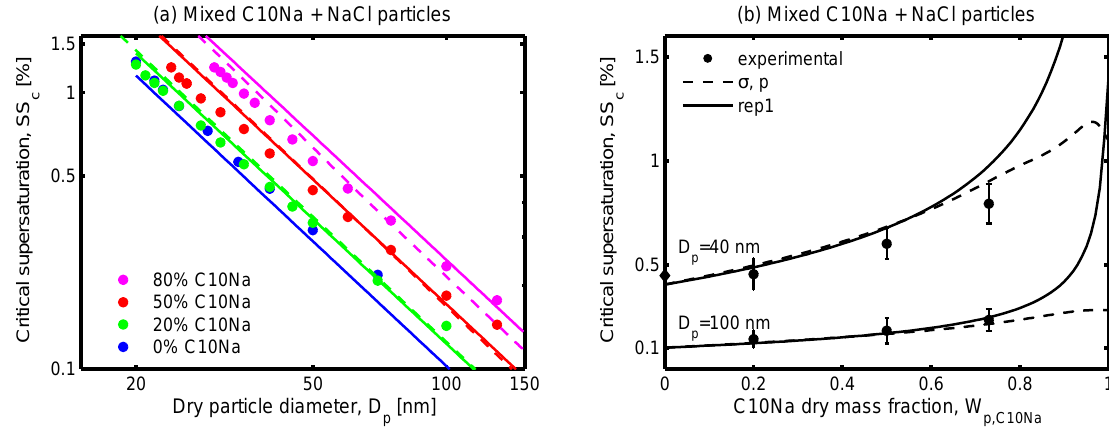
Fig. 3. Critical supersaturations ( SS c [%]) for particles comprising sodium decanoate (C10Na) mixed with sodium chloride (NaCl), as func-